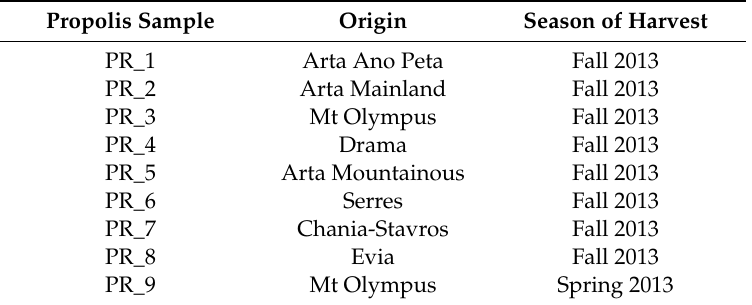
Table 1. Geographical origin and season of harvest of propolis samples used in the study. Propolis